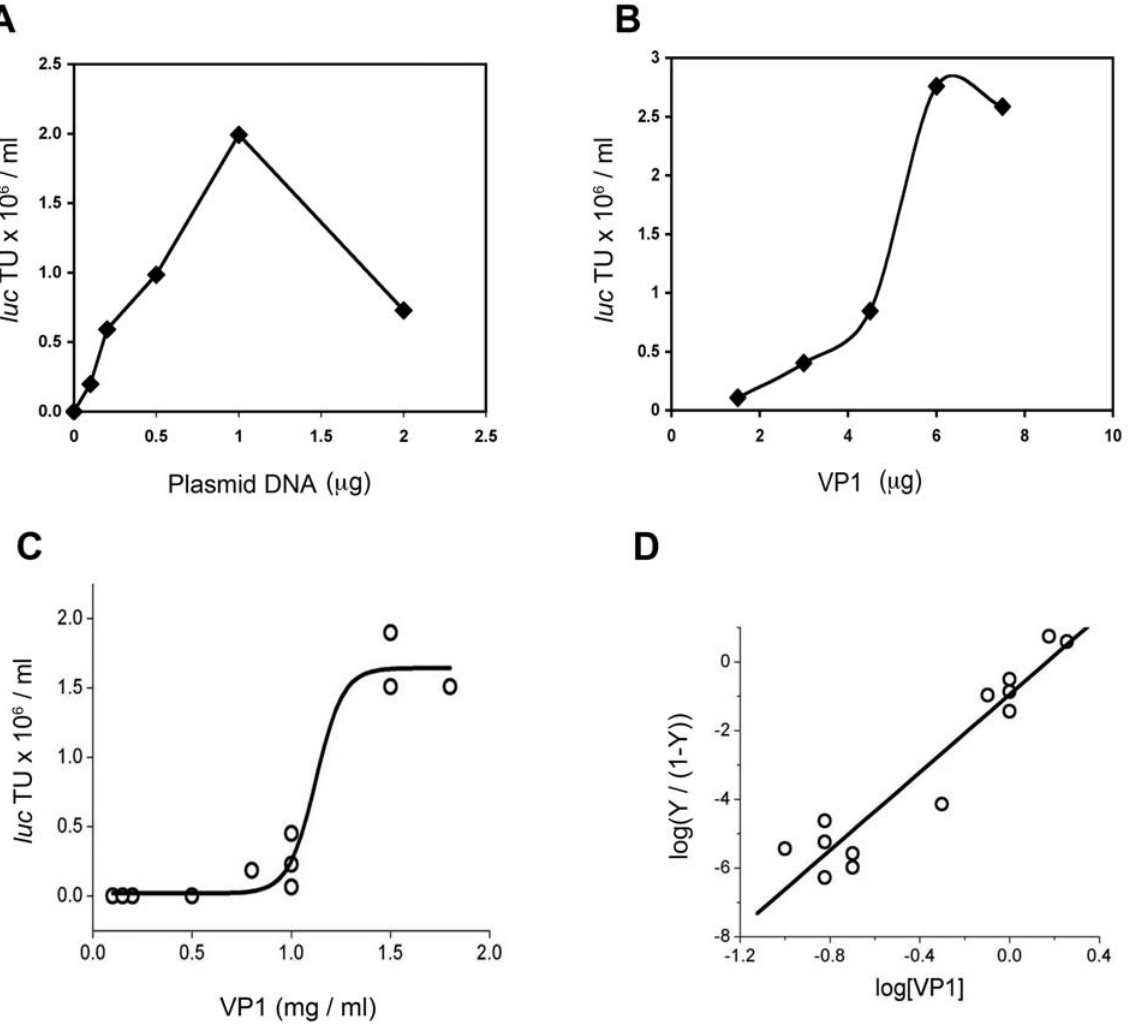
Figure 3. Cooperativity of VP1 in the reaction. Effect of substrate concentration on the reaction yield. A–DNA; B–VP1. The amounts used per reaction, as described in Materials and Methods, is indicated. C-Fourteen different batches of nuclear extracts were assayed for packaging activity. Only 11 distinct data points are seen because of overlap of some of the data points. D-Calculation of Hill coefficient from the same set of data as in C. Y is the fraction of fully assembled VP1, measured as